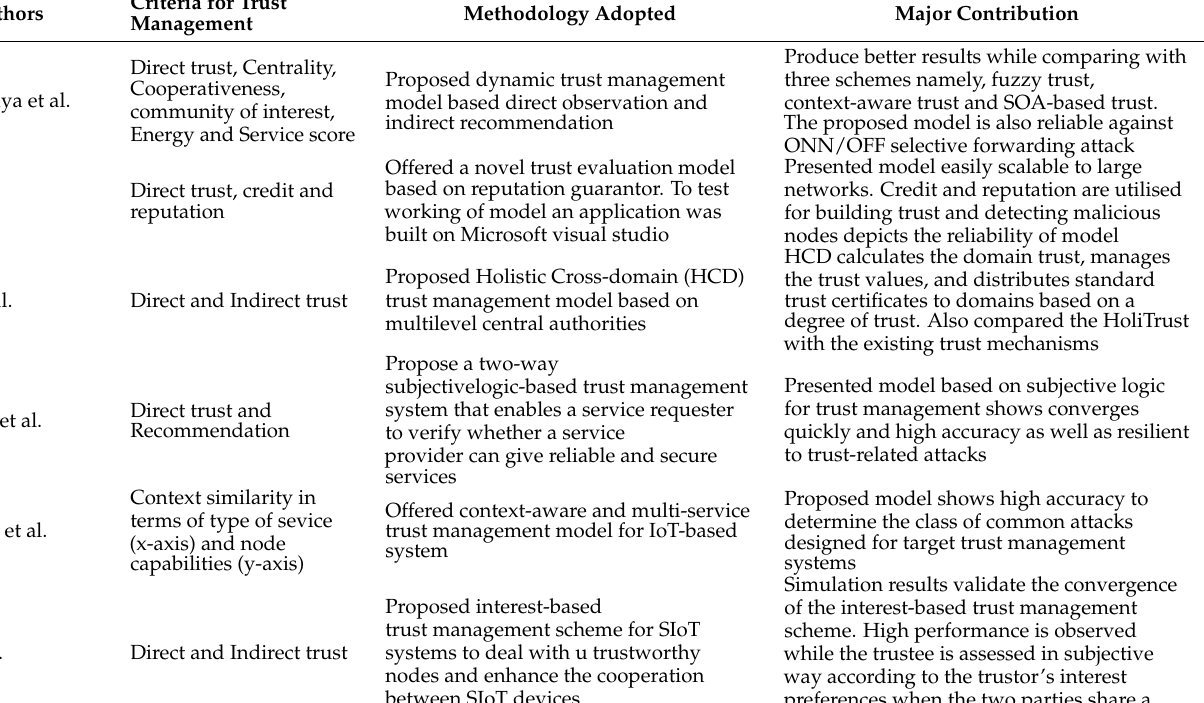
Table 1. Summary of Related